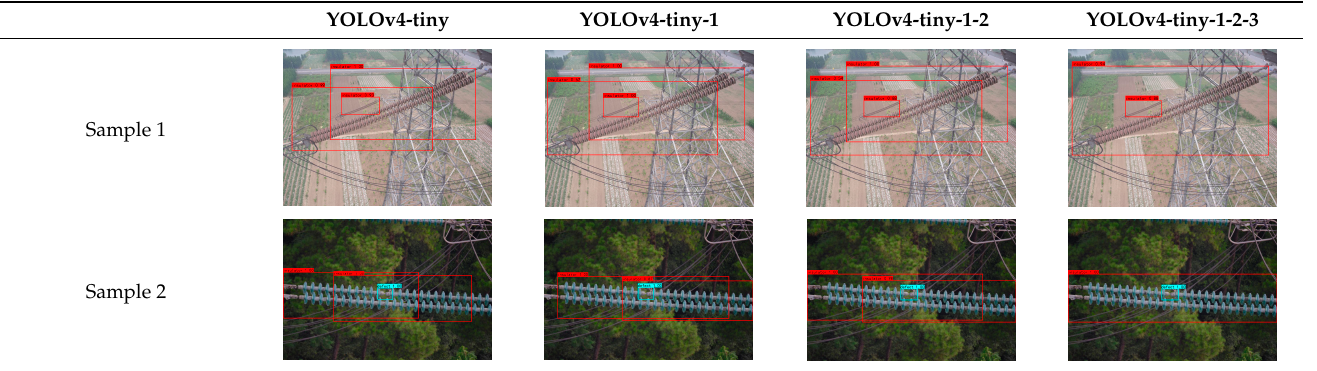
Table 9. Improvement comparison of the split detection boxes.